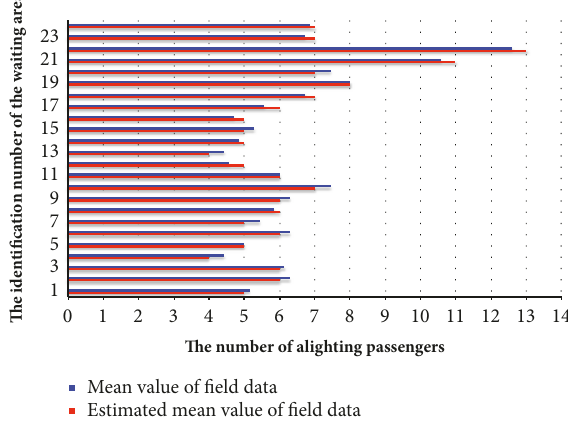
Figure 9: The field numberof passengers at eachwaiting area before being informed of the arrival of a train 𝑁 𝑤 𝑏𝑒𝑓𝑜𝑟𝑒 with Anheqiao North direction.